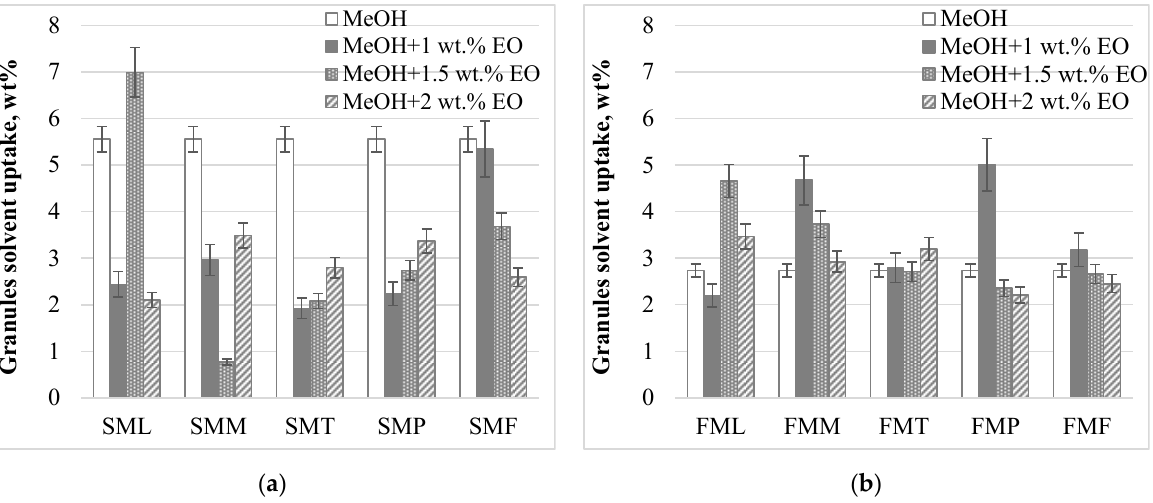
Figure 2. Solvent uptake in methanol at different concentration of essential oil: ( a ) 4043D granules; ( b ) 3D850 granules.